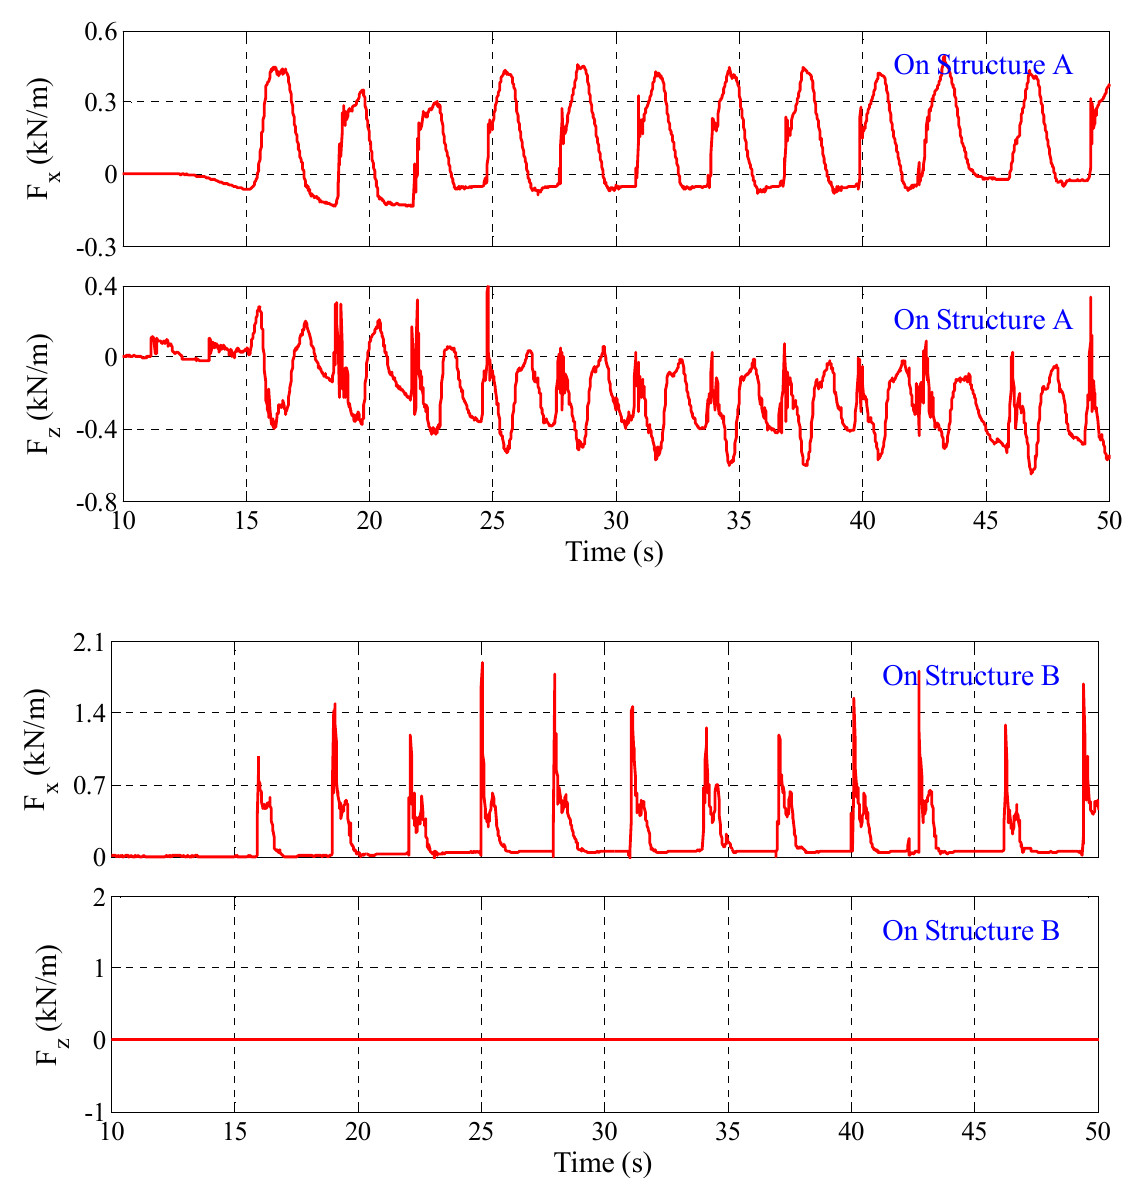
Figure 11. Time history of the impact force on structure A and B applied by regular wave in Test 3.